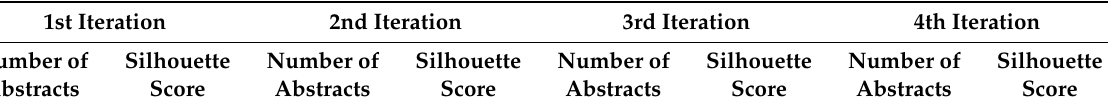
Table 2. The results of four iterations of abstract clustering. Each abstract cluster is labeled with a sequence number #1, #2, and #3,